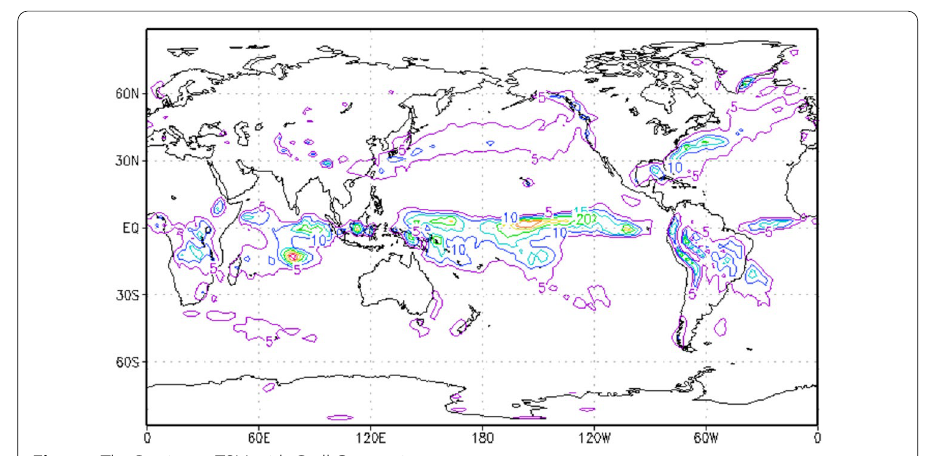
Fig. 17 The Persistent TSM with Grell